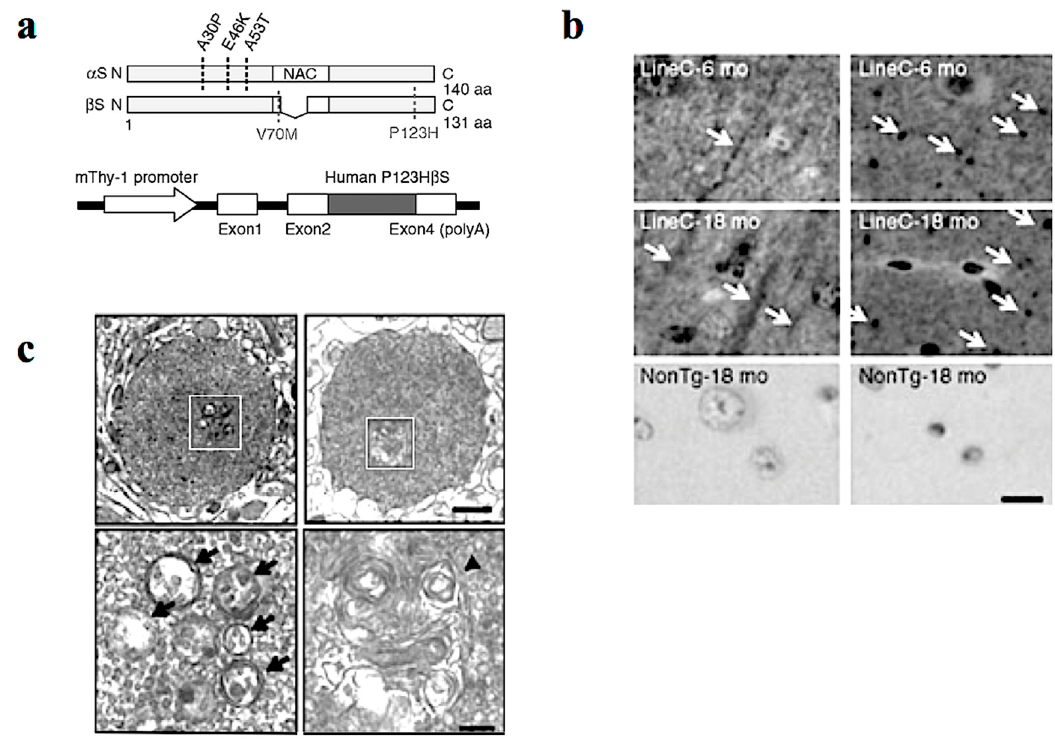
Figure 1. P123H β S tg mice are characterized by a neuritic pathology. ( a ) Generation of P123H β S tg mice. Schematic shows missense mutations of α S and β S identified in α -synucleinopathies. Two α S mutations, A30P and A53T, were discovered in Parkinson’s disease (PD), and another α S mutation, E46K, was later identified in dementia with Lewy bodies (DLB). As for β S, two mutations, V70M and P123H, have been reported in DLB (upper). Diagrammatic representation of the Thy-1–P123H β S construct (lower). ( b ) Immunohistochemistry of P123H β S using anti-P123H β S antibody. P123H β S was accumulated in apical dendrites in the cortex (left panels) and in axonal dots in the hippocampus (right panels) of P123H β S tg mice at 6 and 18 months (mo) (line C), but not in the same regions of non-Tg littermates (NonTg). White arrows indicate that globules were observed in the striatum and globus pallidus of 18-month-old P123H β S tg mice (lines C, arrows), but not in non-Tg littermates. Scale bar = 10 µ m. ( c ) Photomicrographs of the two representative globules in P123H β S tg mice. Electron microscopy revealed that the globules were composed of small vesicles (black arrows) and frequently contained membranous elements such as multivesicular bodies and multilayered membranes (a black triangle). The specific fields surrounded by white rectangles (upper) are enlarged (lower). Scale bar = 1 µ m (upper) and 200 nm (lower). Reprinted with permission from a reference [14].